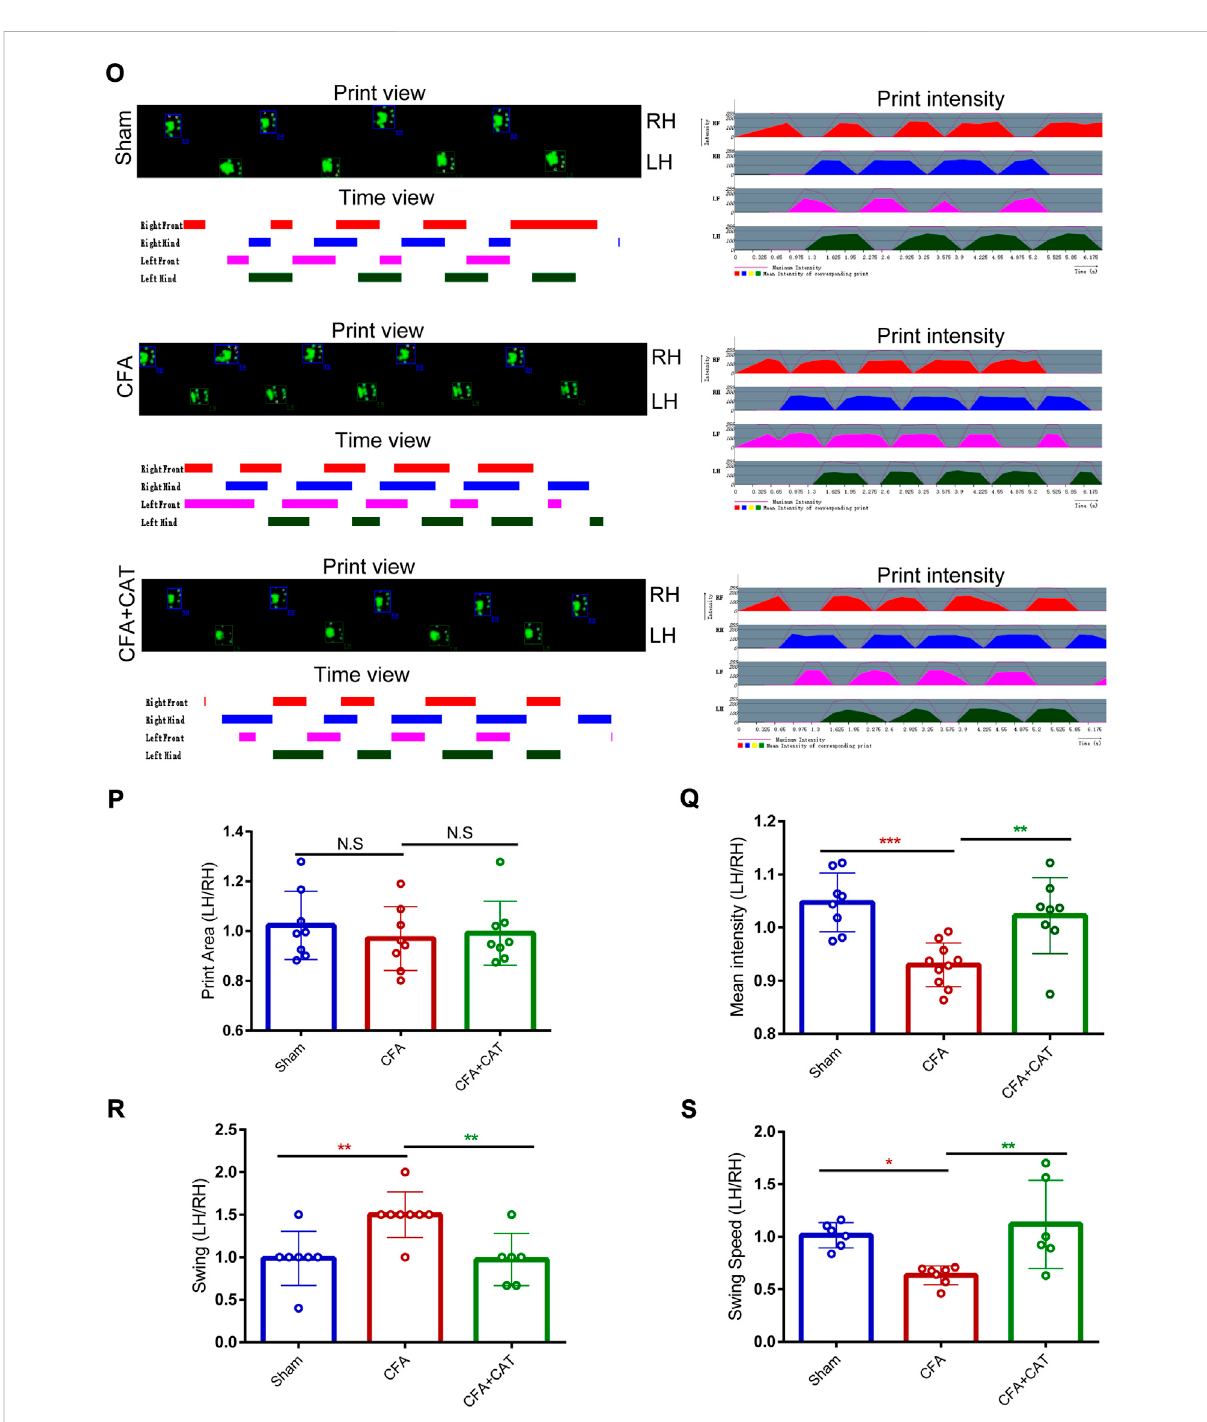
FIGURE 2 Effects of catalpol on Cat Walk gait parameters in CFA rats. (O). Representative CATWALK gait analysis results, including Print view, Timing view and Print intensity. Changes of gait parameters including Print Area (P) , Mean intensity (Q), Swing (R), and Swing Speed (S) in Sham, CFA, and CFA + CAT group. ( p p < 0.05, ** p < 0.01 and ppp p < 0.001 vs. the CFA group; n = 8, one-way ANOVA). All data were calculated as left hind paw/right hind paw (LH/RH) formula to eliminate the effect of confounding factors. LH: left hind paw; RH: right hind paw; N.S. not statistically signi fi